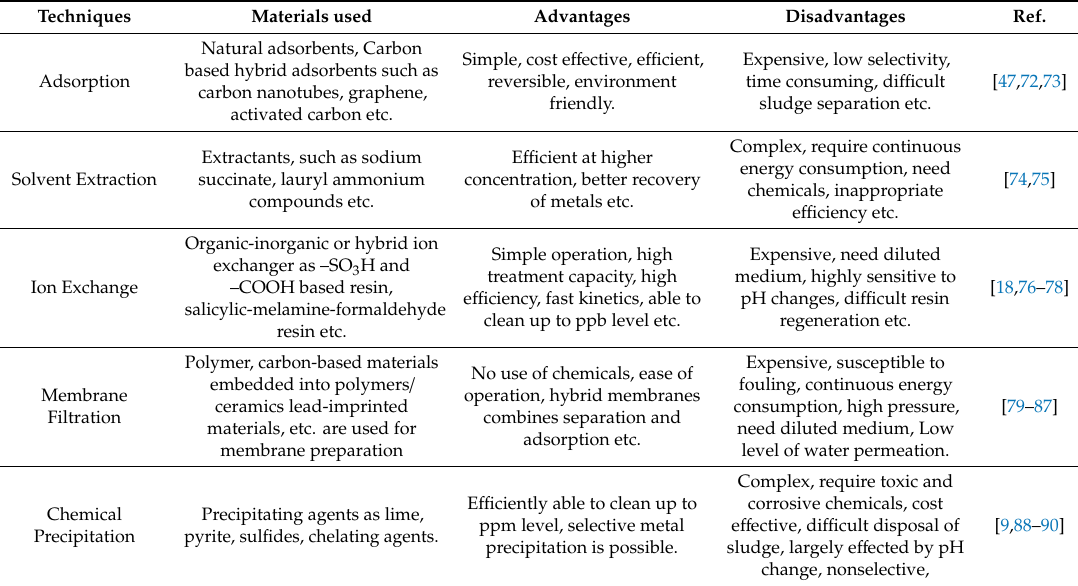
Table 1. Techniques characteristics used for Pb(II)